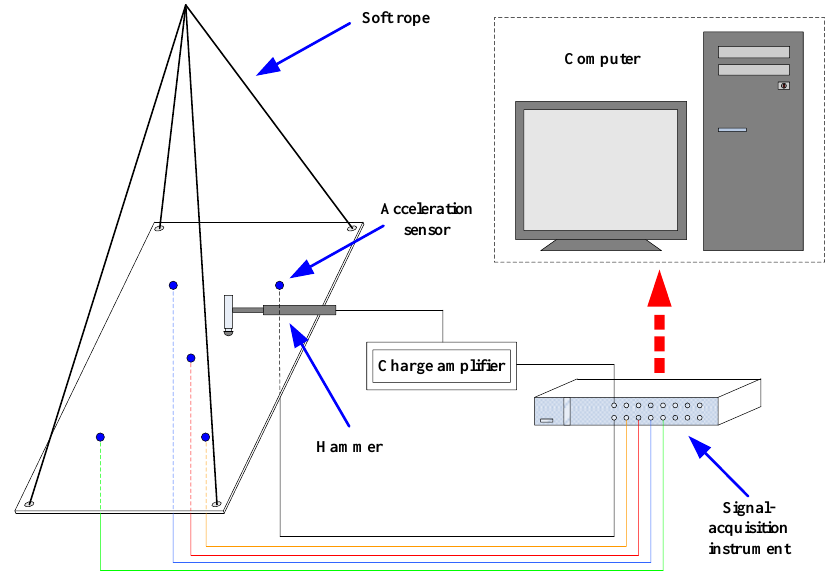
Figure 4. Schematic diagram of the impact experiment.